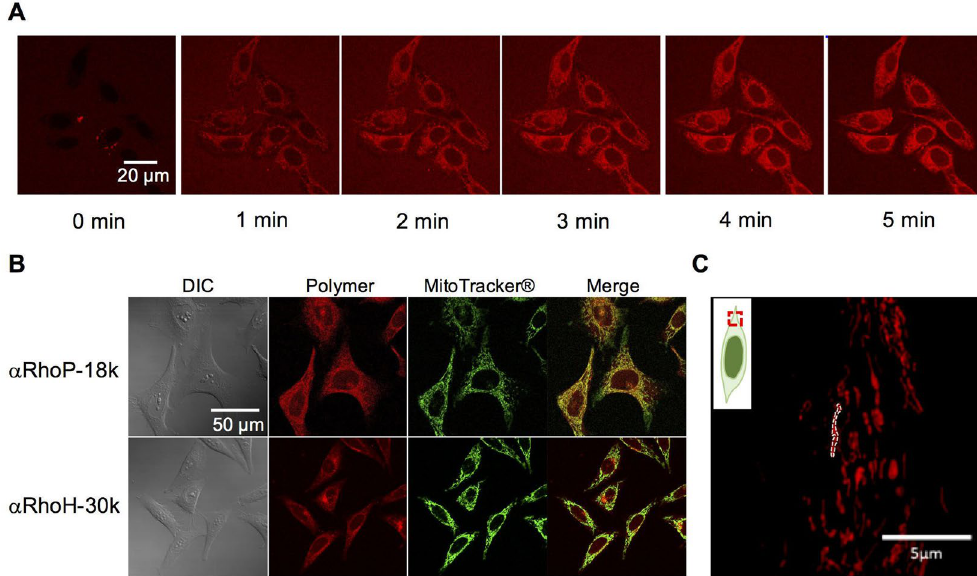
Figure 3. ( A ) Micrographs of HeLa cells at various times post treatment with α RhoP-18k. α RhoP-18k (1.0 mg/ mL) was added in the presence of serum. Micrographs were recorded from 0 to 5 min. ( B ) Colocalization of α RhoP (Red) and MitoTracker ® (Green) in HeLa cells. After 1 h treatment of α RhoP-18k (upper) and α RhoH- 30k (lower) in the presence of serum, MitoTracker was added to the cells. ( C ) Super resolution fluorescence micrograph of α RhoP-18k added to HeLa cell. The white dotted line outlines a mitochondrion. The inset gives a schematic representation of the part of the cell